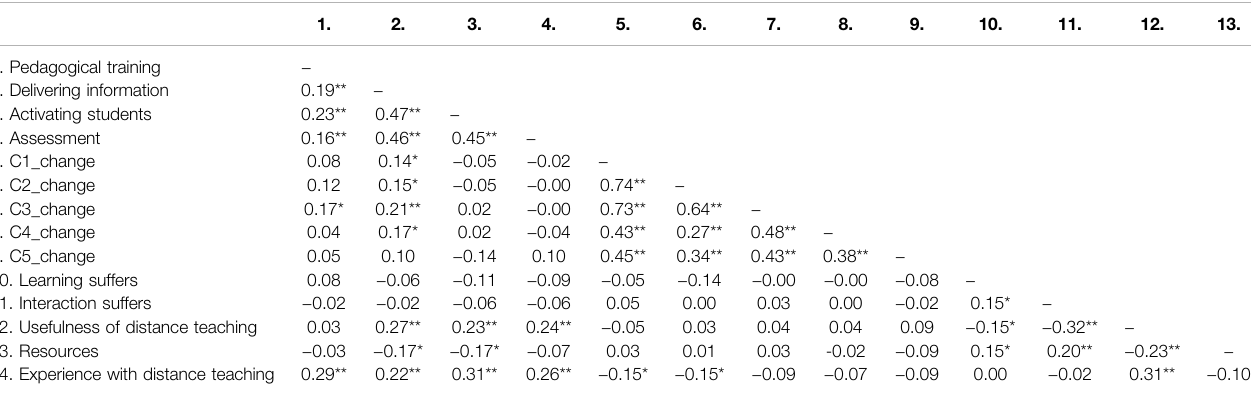
TABLE 5 | Pearson correlations between the main variables and changes in